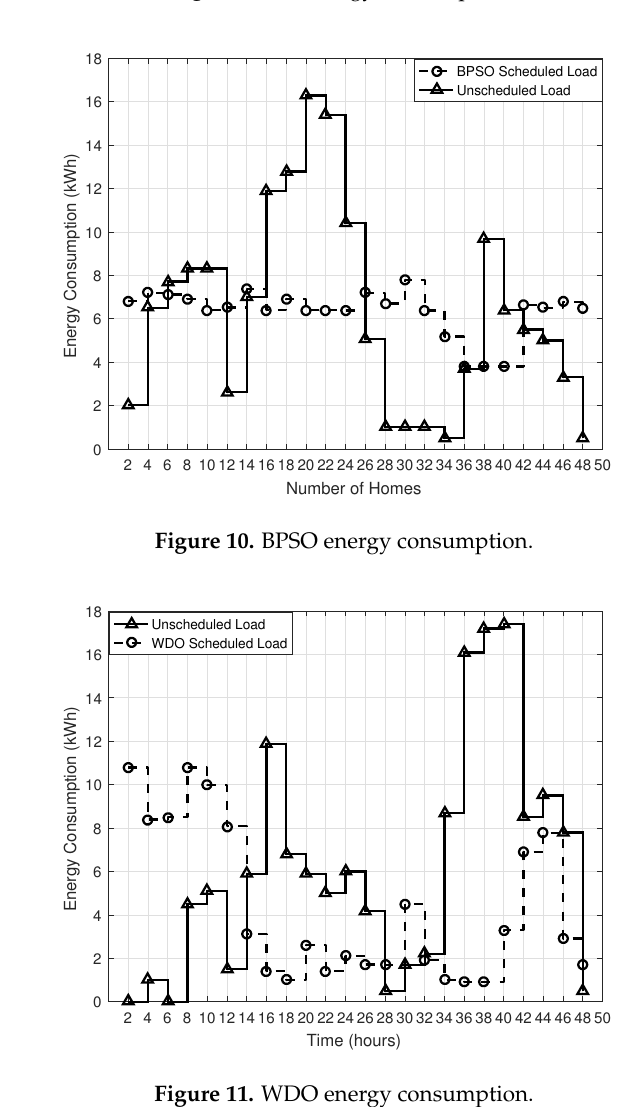
Figure 9. GA energy consumption.